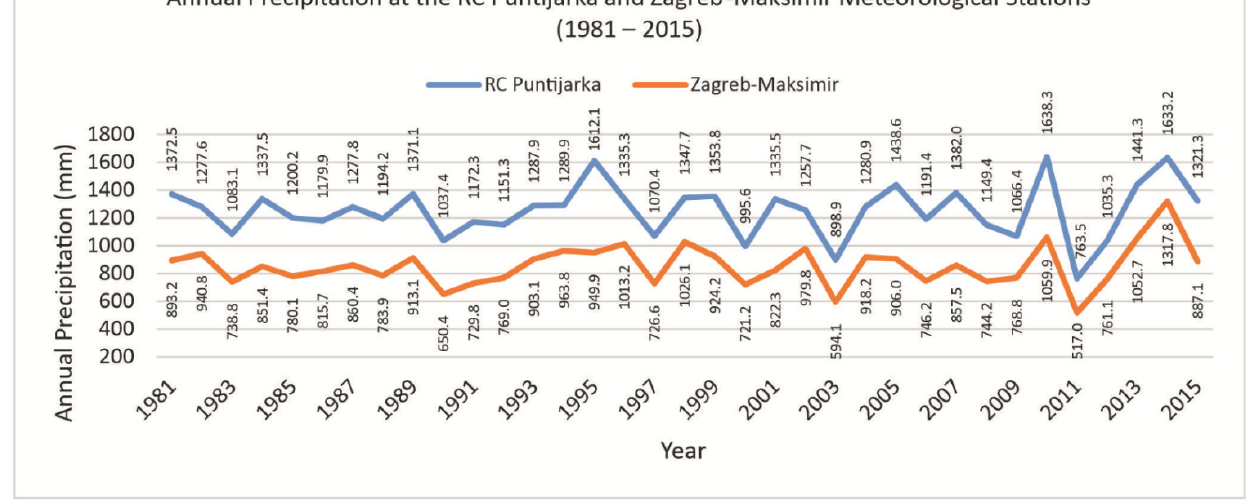
Figure 2. Annual mean precipitations on the “RC Puntijarka” and “Zagreb-Maksimir” station between 1981 and 2015.